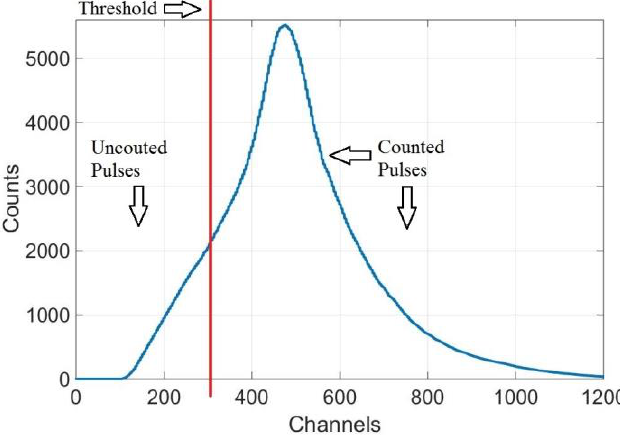
Fig.4 . Normalized pulse-height spectrum of the high sensitivity FC with a 235U to set into the FC signal simulator.